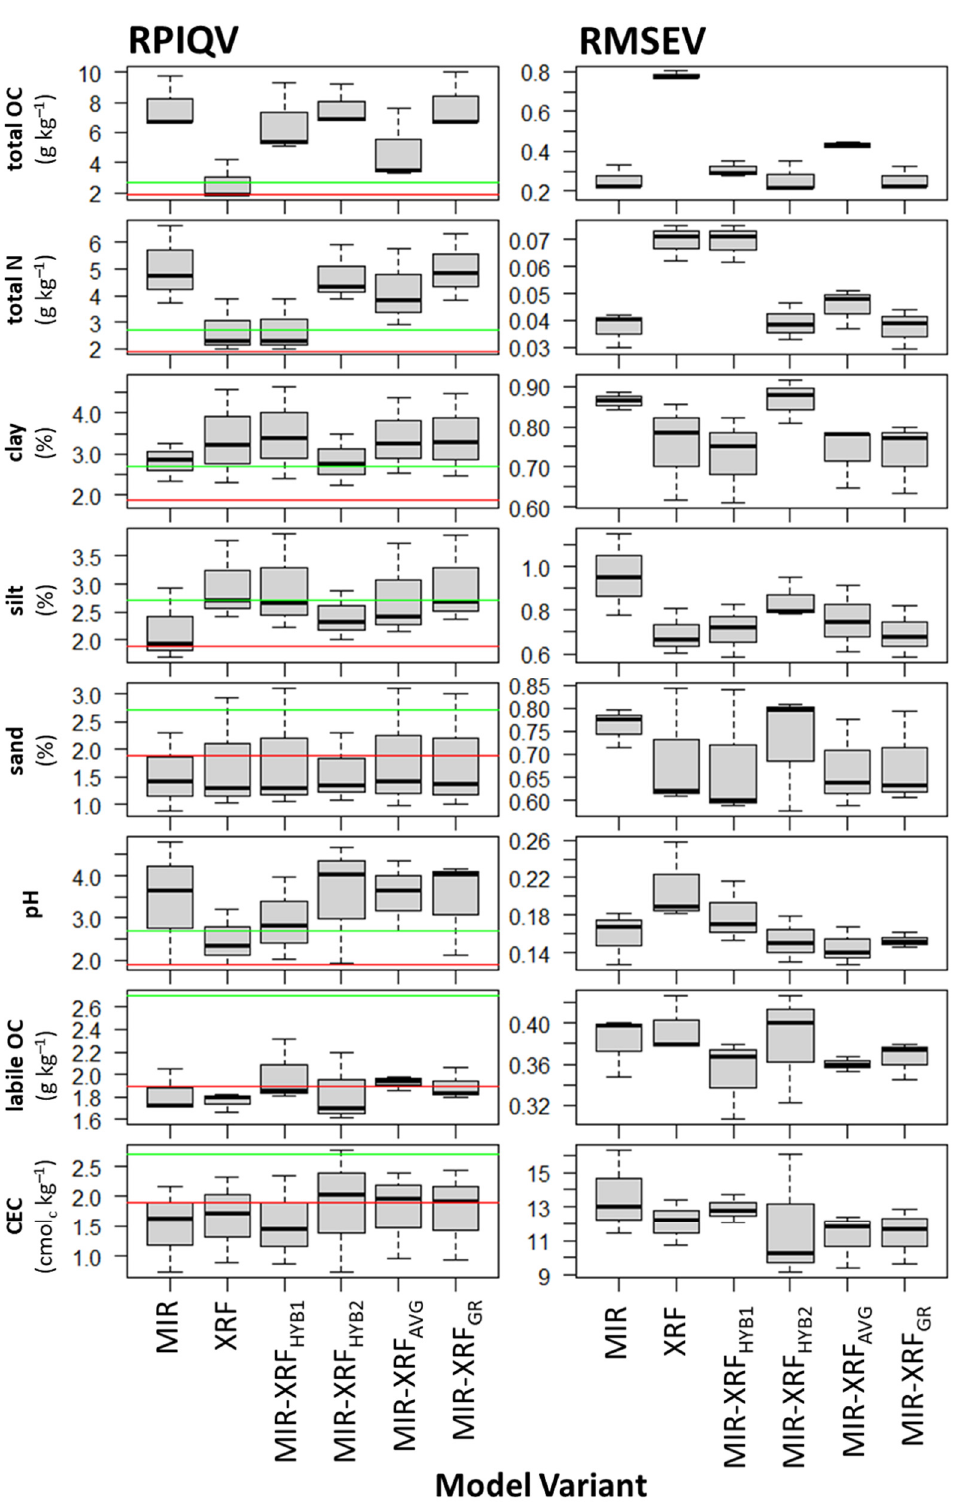
Figure 2. Validation RPIQ and RMSE for the model variants across the three dataset partitions. RPIQV values below the red lines refer to poor model accuracy (<1.89) and values on and above the green lines refer to very good model accuracy ( ≥ 2.70). See Table 1 for definitions of model variants.